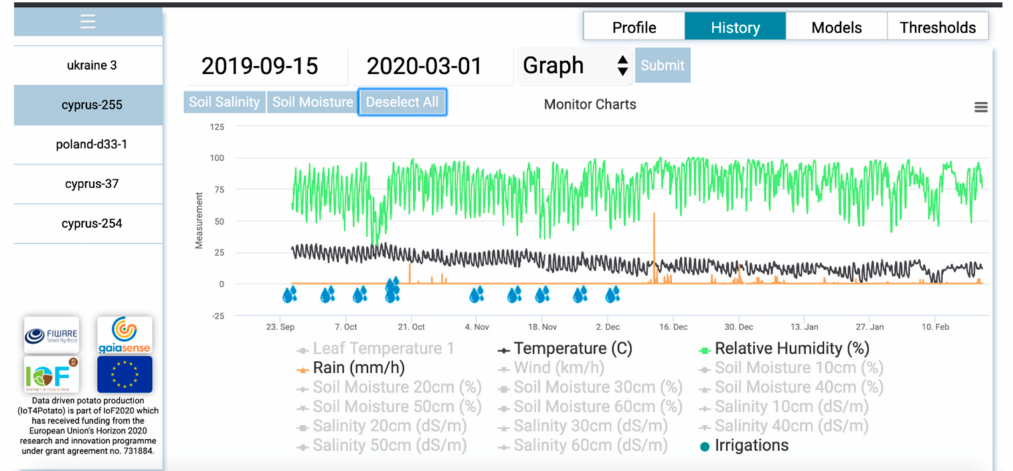
Figure 5. History of recorded agro-environmental measurements for the selected parcel are rendered to the